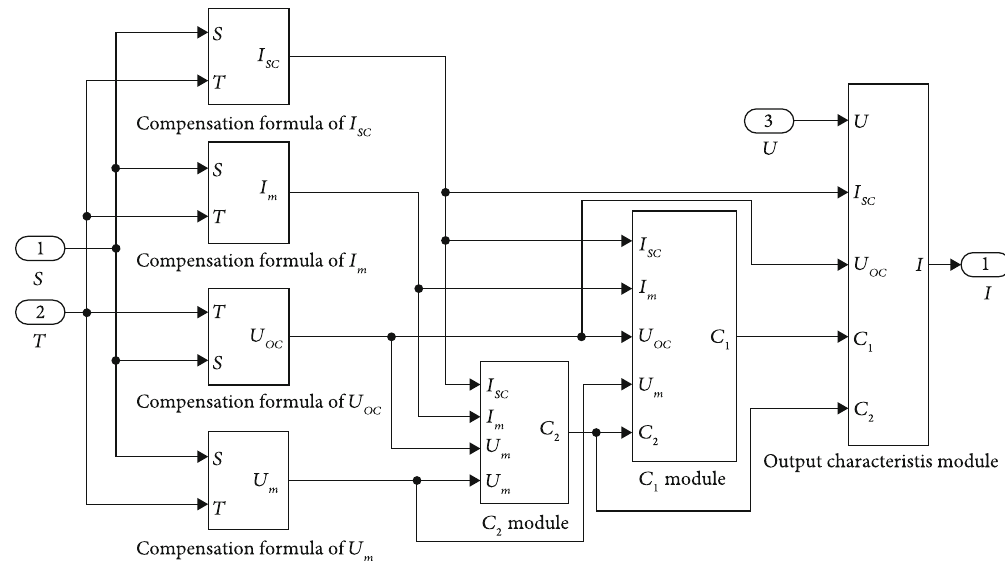
Figure 1: Photovoltaic simulation model.